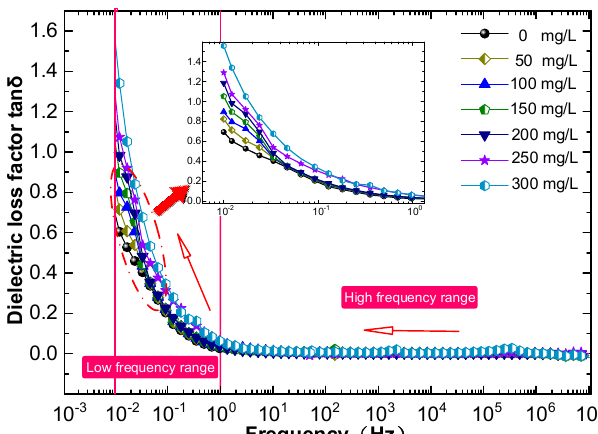
Figure 9. Broadband dielectric loss spectrum of CMIO and FO.